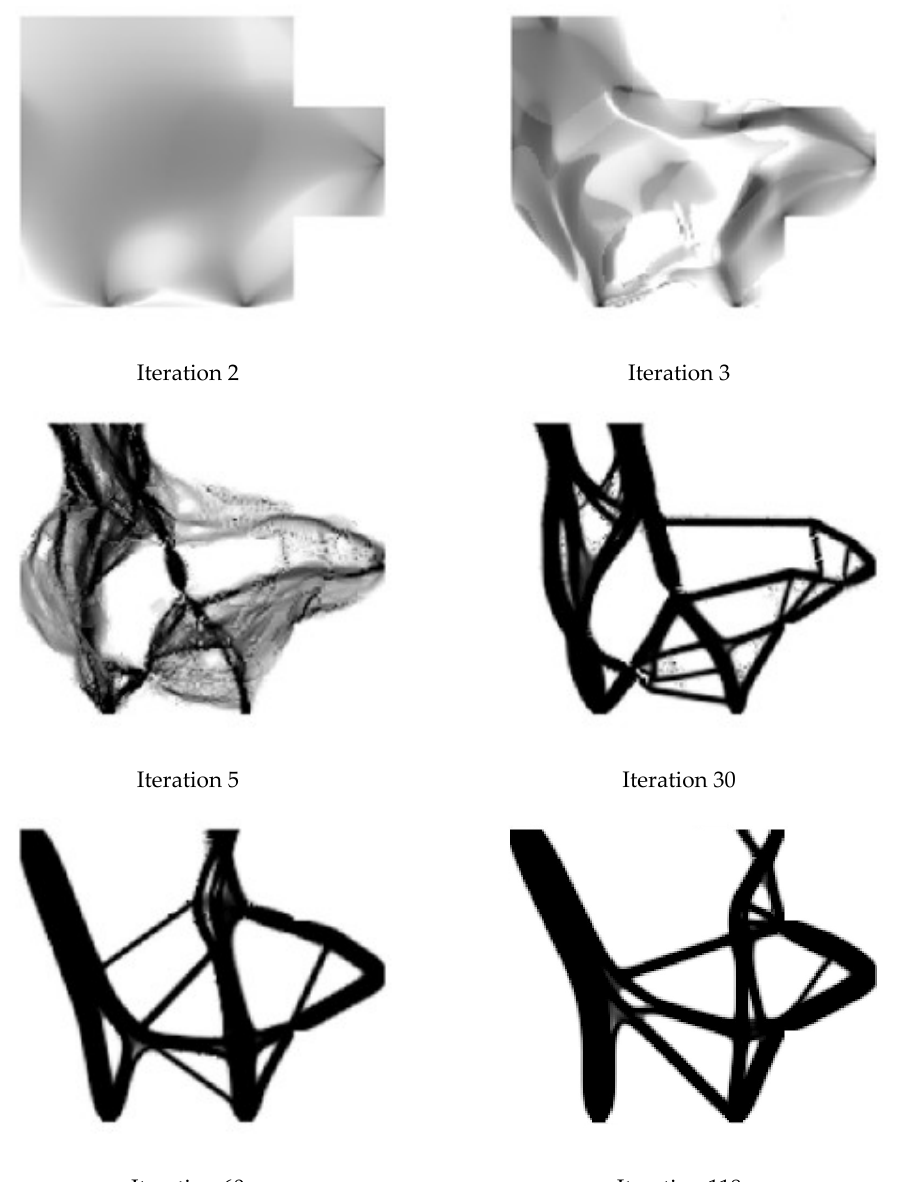
Figure 9. Evolution of the structural configuration optimized using Equation (13). Tables 1 and 2 provide the exact values of desired and undesired displacements as well as output and input coupling indices, and we can evaluate the output performances of the two design results shown in Figures 7 and 8 quantitatively. The absolute values of all the undesired displacements (cid:101) u O 2,1 , (cid:101) u I 2,1 , (cid:101) u O 1,2 and (cid:101) u I 1,2 related to the path generator drawn in Figure 8 decrease significantly, and accordingly the values of the coupling indices δ 2,1 , δ 1,2 , γ 2,1 and γ 1,2 are all quite small and not bigger than [ δ ] = [ γ ] = 0.01. Such results manifest that both input and output couplings are under